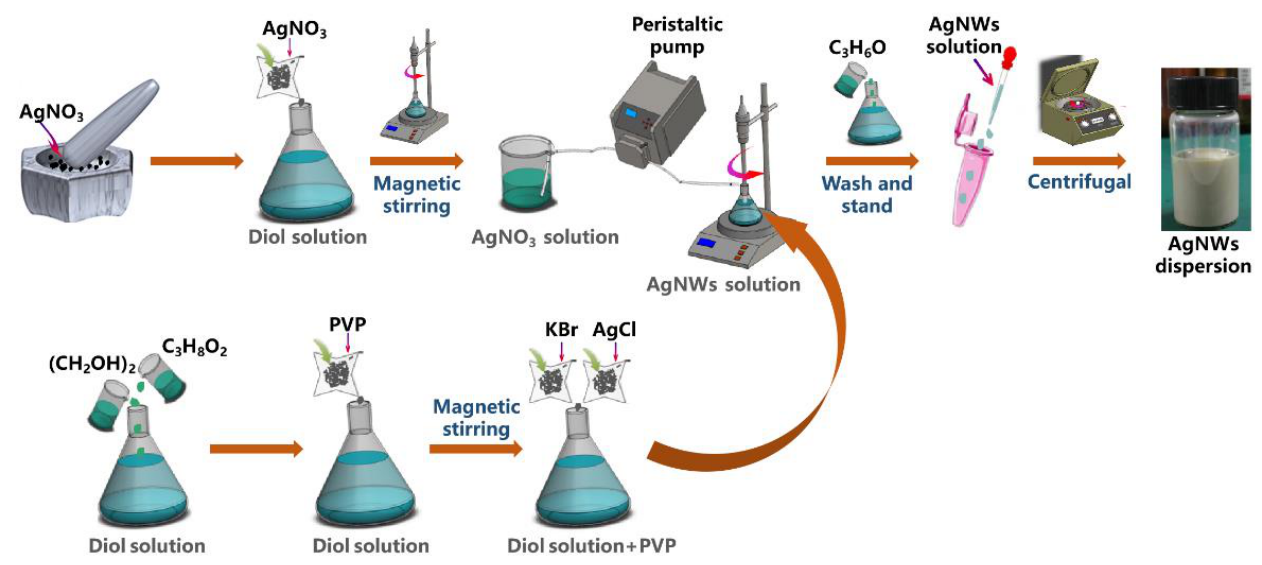
Figure 1. Schematic illustration of preparation of AgNWs.